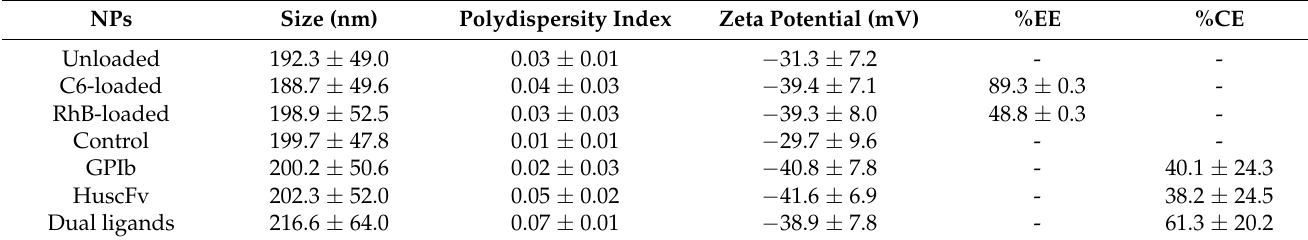
Table 1. Sizes, polydispersity indices and zeta potentials of fabricated NPs by